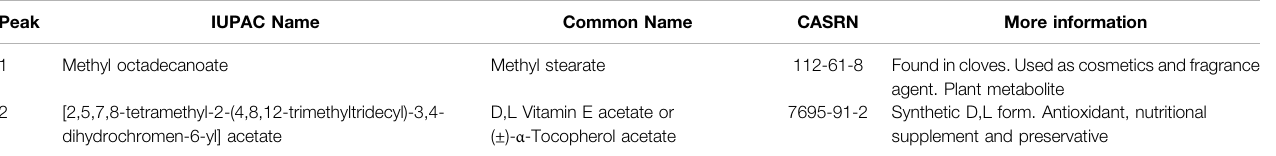
TABLE 2 | Chemical compounds detected in Vitamin E Acetate ( Figure 4